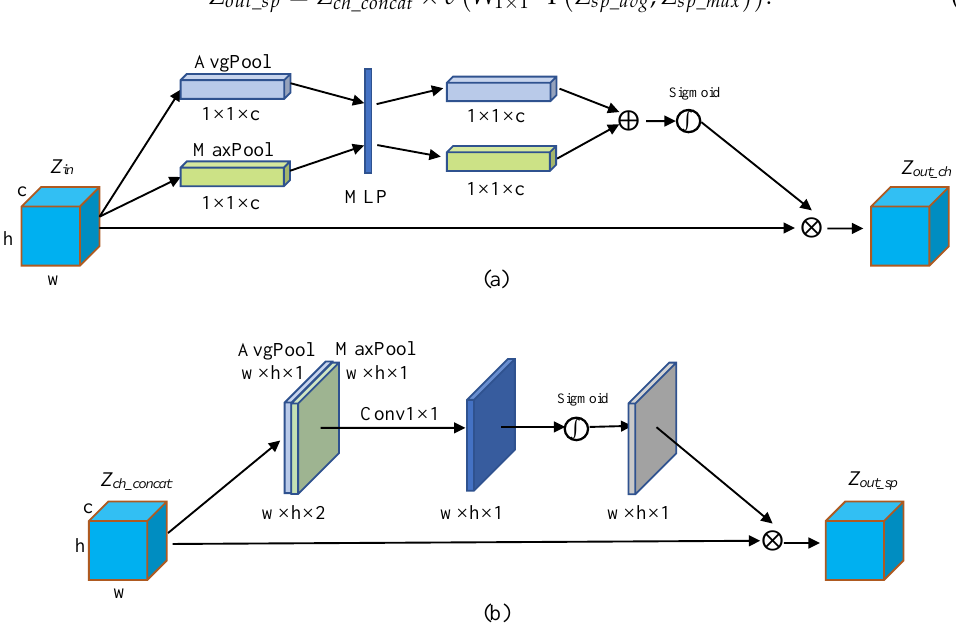
Figure 4. The structure of attention modules. ( a ) Channel attention module; ( b ) spatial attention